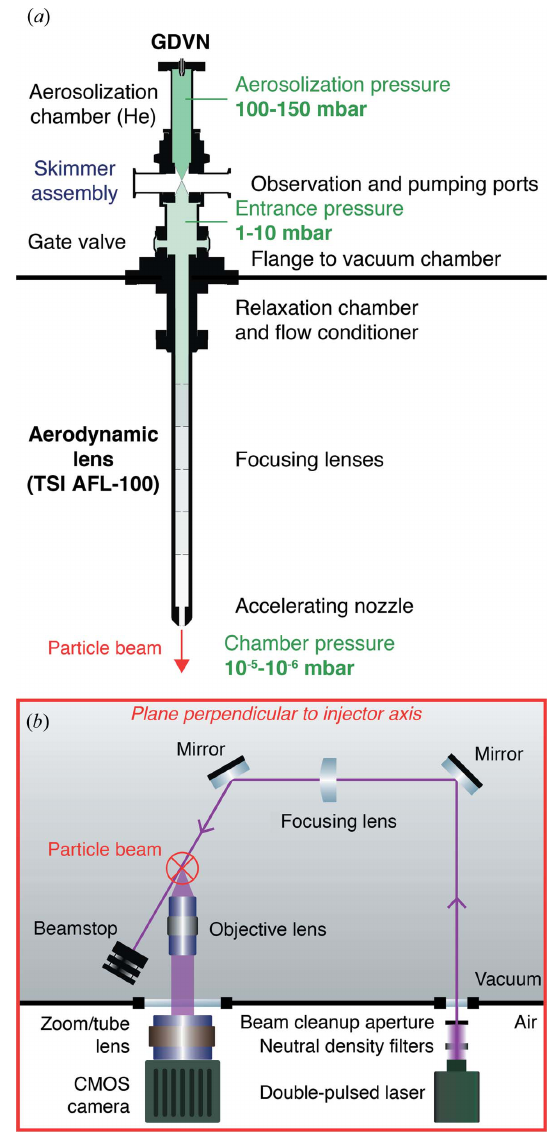
Figure 1 Experimental setup. ( a ) Section of the Uppsala injector along the particle-beam axis. The injector is equipped with a gas dynamic virtual nozzle (GDVN) for sample aerosolization, a skimmer for excess-gas removal and an aerodynamic lens for particle-beam focusing. ( b ) Schematic of the Rayleigh-scattering-microscopy setup. The optical beam path is confined to the plane perpendicular to the injector axis [view perpendicular to image plane in ( a